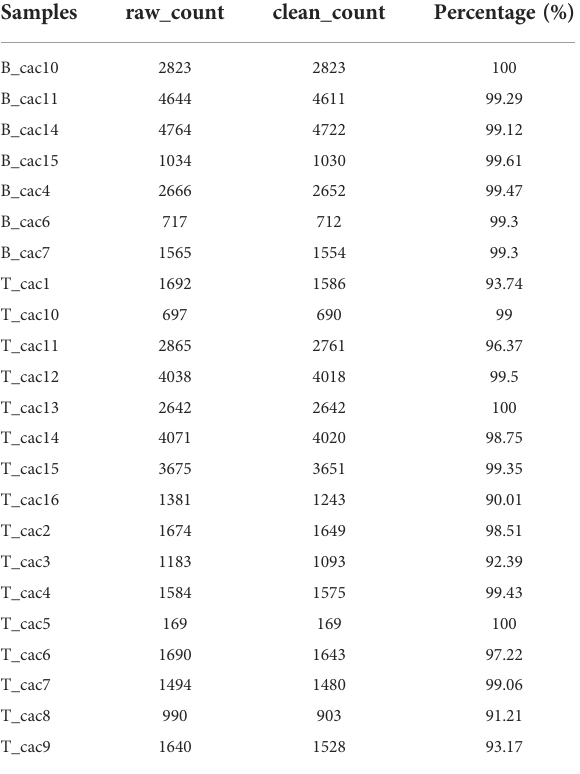
TABLE 1 Counting of cell counts before and after sample fi ltration.